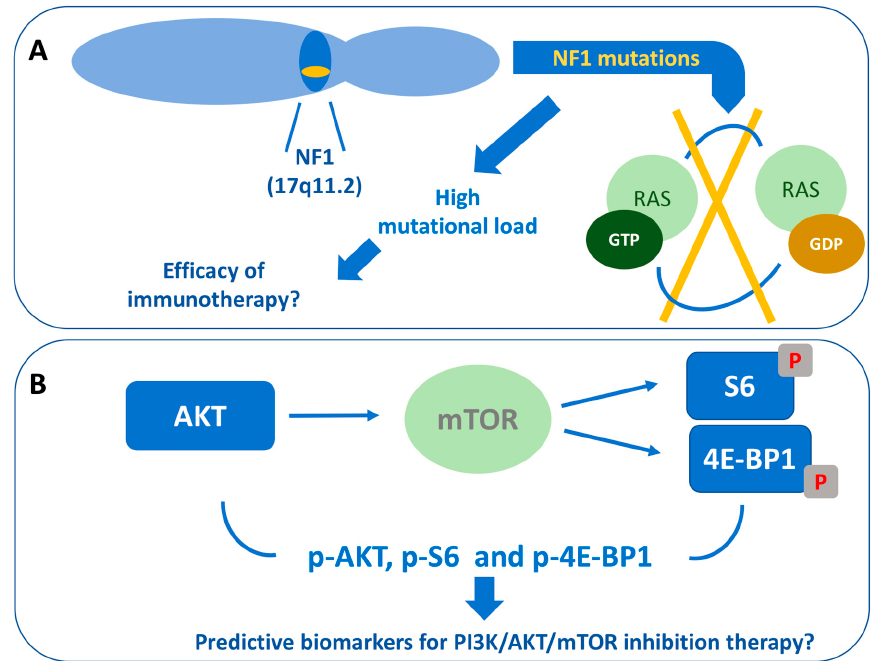
Figure 3. Potential molecular predictive factors for immunotherapy or target therapy in conjunctival melanoma. ( A ) NF1 (17q11.2) mutations, which cause the loss of RAS-bound GTP hydrolysis, are associated with high mutational load and could help to predict the e ffi cacy of immunotherapy; ( B ) High levels of AKT, phosphorylated S6 and 4E-BP1 are related to mTOR mutation and could predict the e ffi cacy of PI3K / AKT / mTOR inhibition